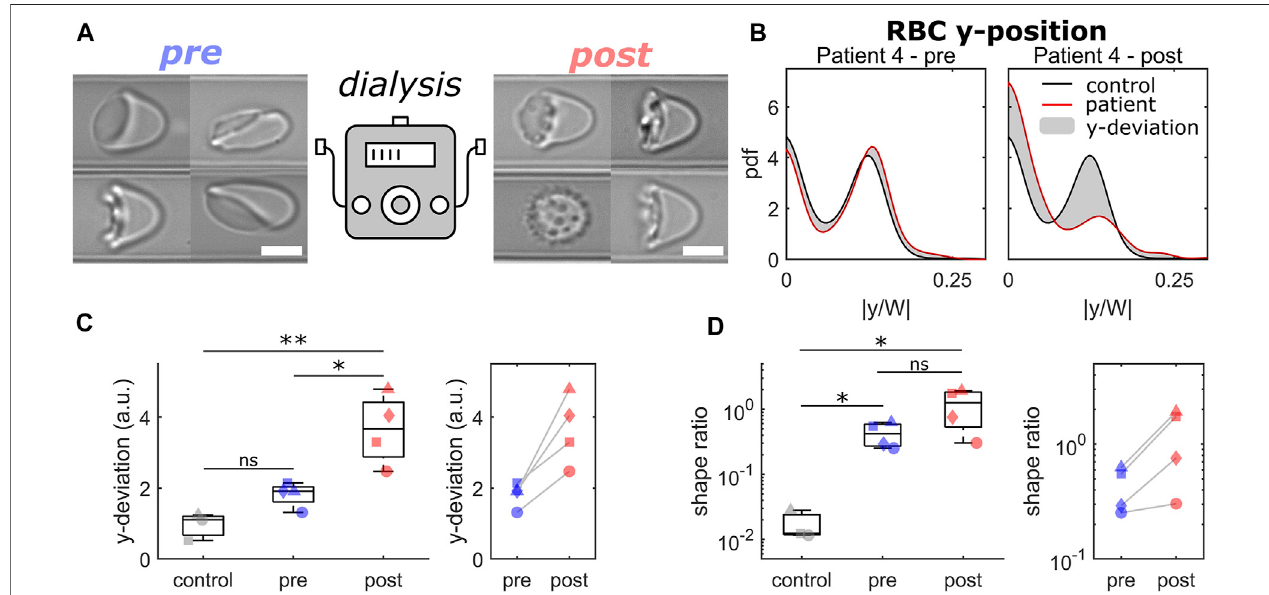
FIGURE 3 | Comparison of RBCs from patients before and after dialysis by hemodia fi ltration. (A) Representative RBC shapes pre (left) and post (right) hemodia fi ltration. Scale bars represent 5 µm. (B) Probability density functions (pdfs) of the normalized cell ’ s center-of-mass position at v = 5 mm/s. Black and red lines represent the pdfs for a healthy control and for patient 4 pre (left) and (post) hemodia fi ltration. The gray area indicates the difference between both pdfs. (C) Deviation betweenthey-positiondistributionsbased onthe averagedistribution forhealthy controlsfor avelocityrangeof1 – 10 mm/s. (D) Shape ratiobetweenpathological and healthy RBC shapes in the velocity range of 1 – 3 mm/s. Data shown with the same symbols in (C) and (D) correspond to the same patient pre and post hemodia fi ltration.*referstoasigni fi cancelevelof p < 0.05,**to p < 0.01,andnsstandsfornotsigni fi cant.Theanalysispresentedwasperformedonanaverageof4006 cells per patient/donor (between 2895 and 5496